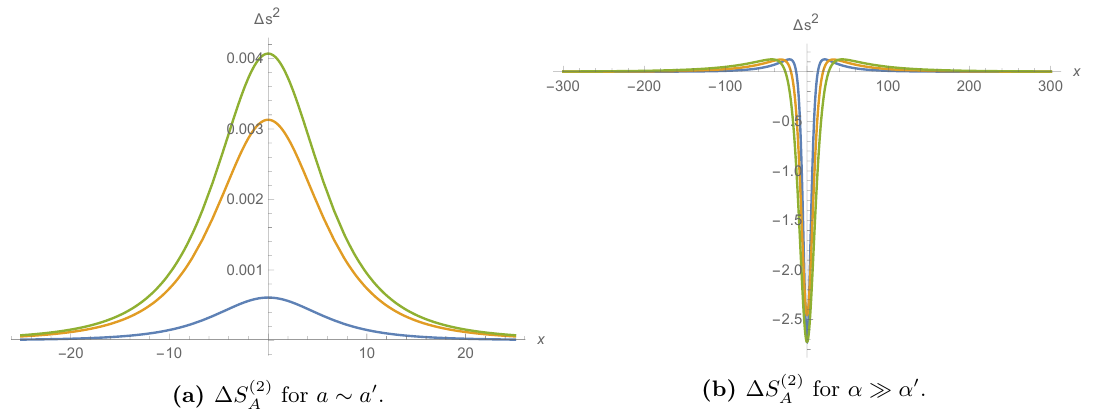
Figure 4. ∆ S (2) as a function of the center of the operators F rθ A